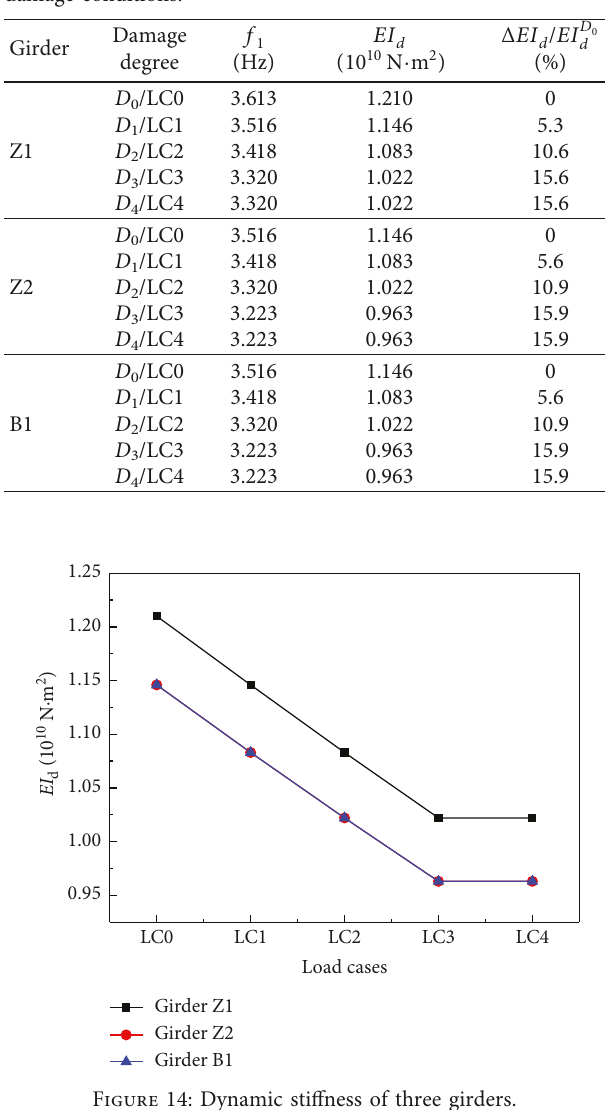
Table 8: Dynamic stiffness of the test girders under different damage conditions.